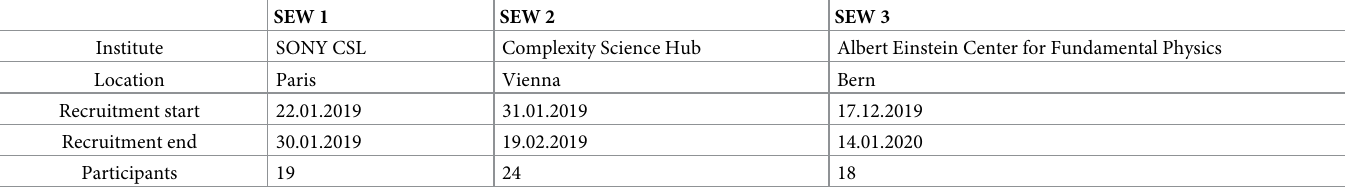
Table 1. A table detailing location, recruitment periods and number of participants for the scientific evolutionary